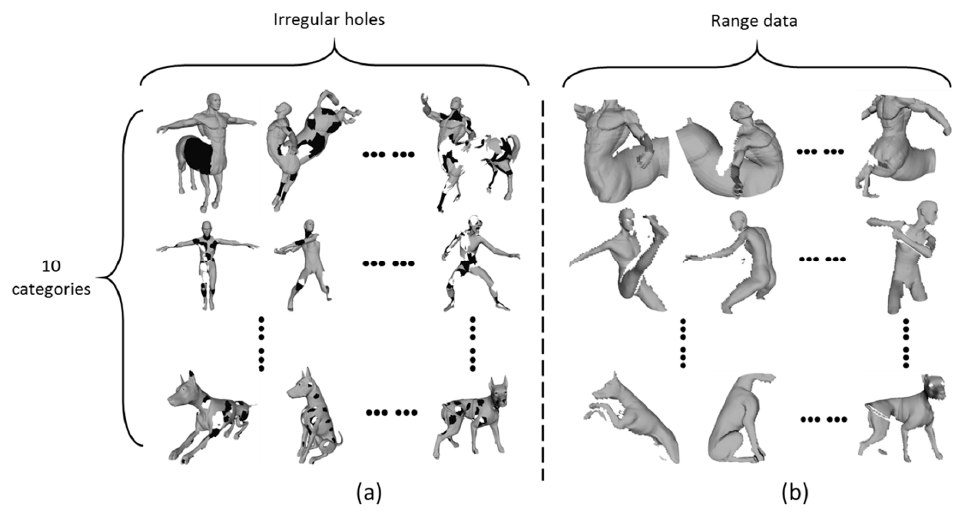
Figure 4. Examples of 3D models in SHREC’17 Deformable Shape Retrieval with Missing Parts . ( a ) Irregular holes; ( b ) Range data.